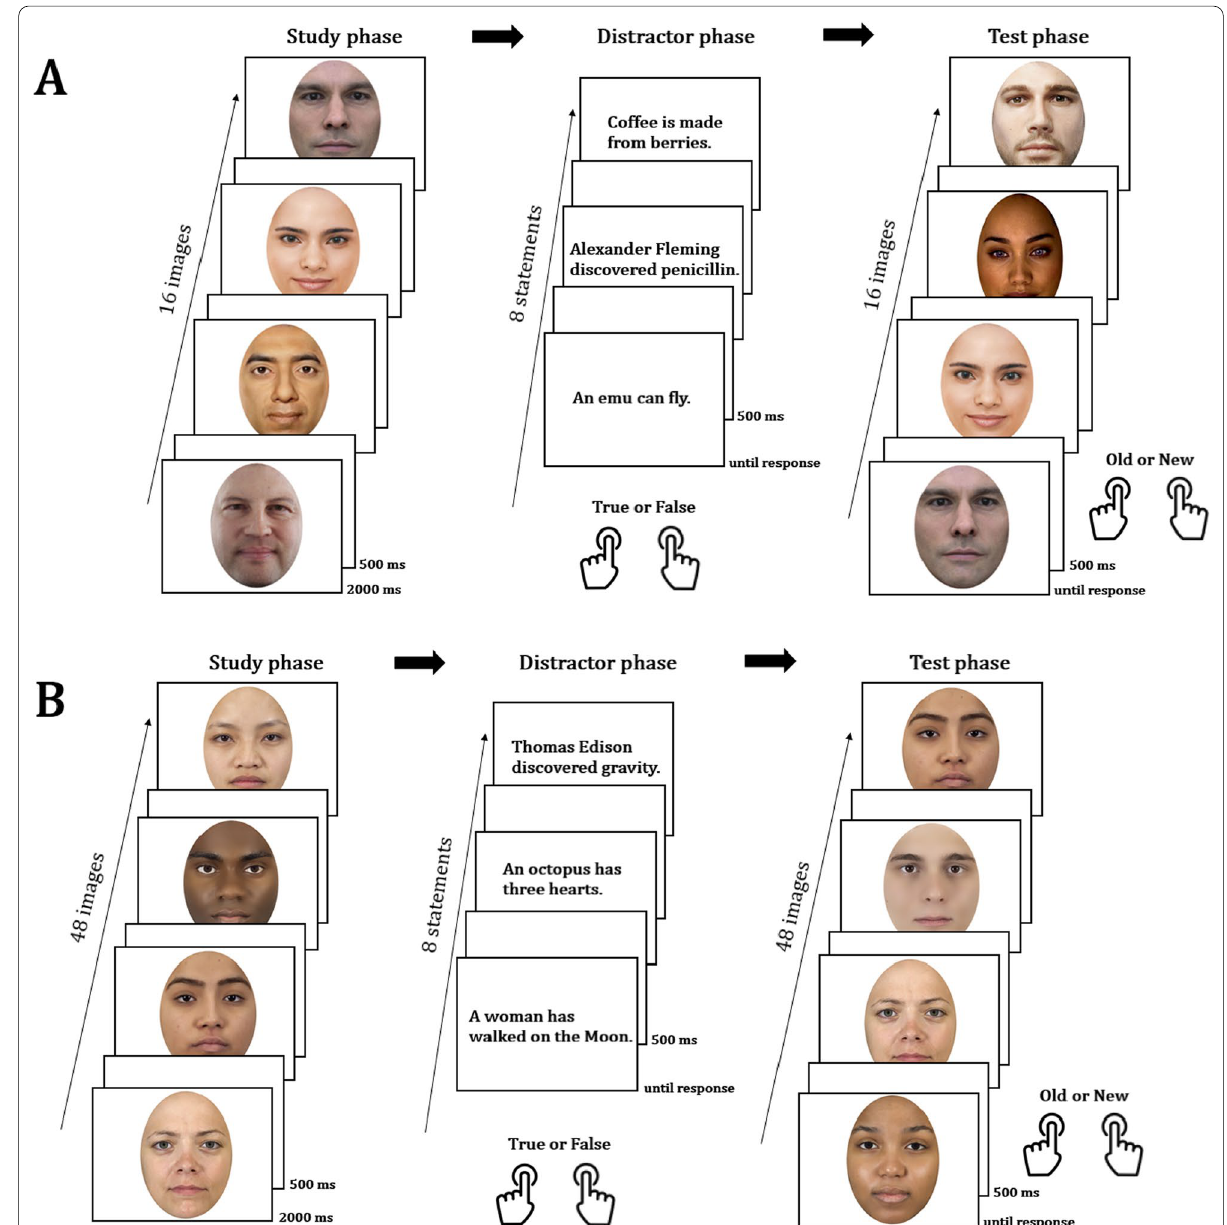
Fig. 1 Schematic overview of the experimental procedure in A Experiment 1 and B Experiment 2. In the “study” phase, participants saw each face presented on the screen for 2000 ms followed by a blank screen that was presented for 500 ms. In the subsequent distractor phase, participants read statements and indicated their veracity. Finally, memory was tested in the “test” phase by presenting half of the earlier presented images in addition to new facial